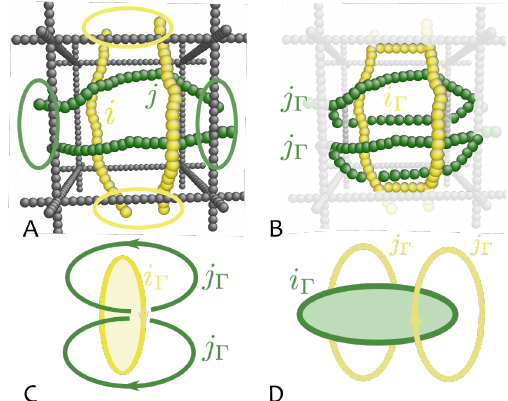
Figure 3. A strategy to identify threadings. ( A ) Consider a pair of rings sharing a unit cell of the gel and identify the points where contours cross the edges of the cell. ( B ) Close the contours asymmetrically: the first (yellow) by following the shortest path between exit points. The other (green) strands by extending their paths away from the cell and by joining each strand separately.The surrounding structure (dark grey) is then removed (light grey). ( C ) The resulting situation allows one to identify threadings: the two new rings originating from the second (green) ring are linked to the first new contour if, and only if, the first ring is threaded by the second. ( D ) In all other cases, the new contours are not linked with one another (adapted from Reference